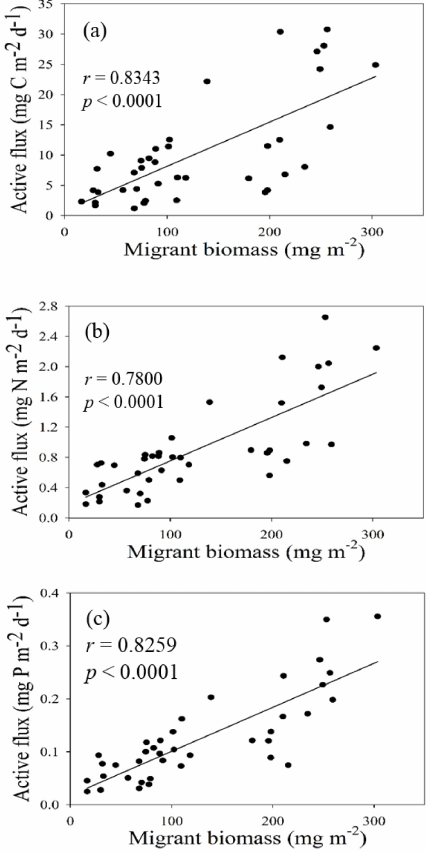
Figure 8. Plots of statistic correlations between migrant biomass and active carbon fluxes (a) , active nitrogen fluxes (b) , and active phosphorus fluxes (c)